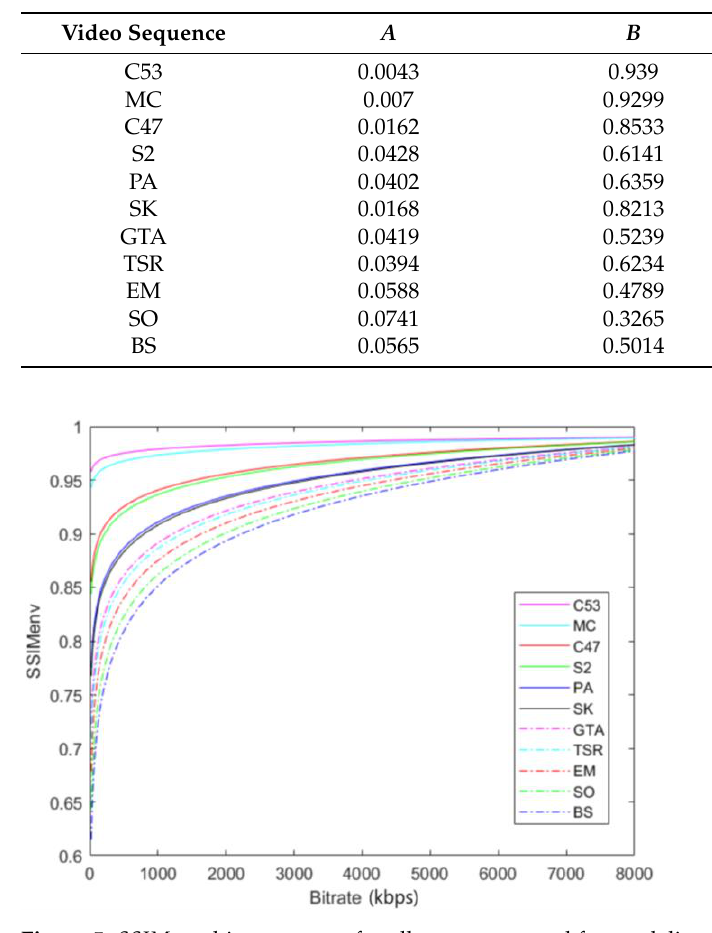
Figure 5. SSIMenv –bitrate curves for all sequences used for modeling.